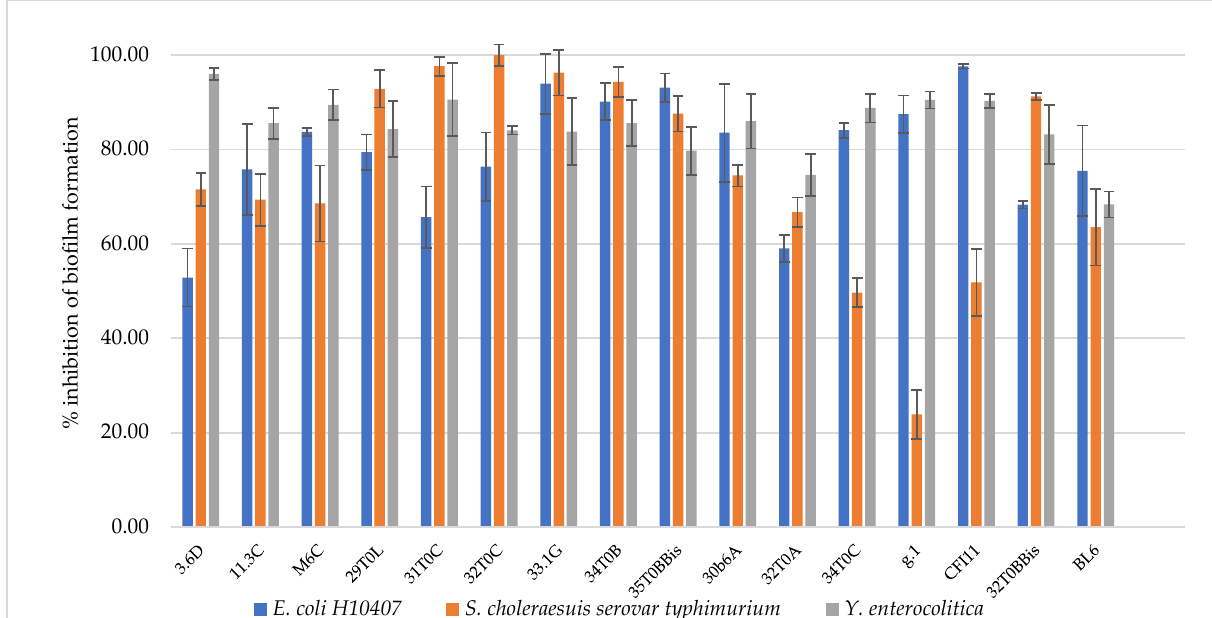
Figure 3. Inhibition of pathogen biofilm formation by L. plantarum 3.6D, 11.3 C, M 6 C, 29 T0 L, 31 T0 C, 32 T0 C, 33.1 G, 34 T0 B, 35 T0 B.Bis, 30 b6 A, L. gasseri 32T0A, 34 T0C, g.1, C F l11, B. longum 32T0B.Bis, B. animalis BL6.